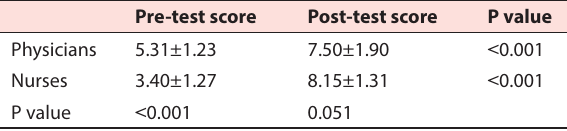
Table 2. Results of participants in 2 groups: nurses and physicians